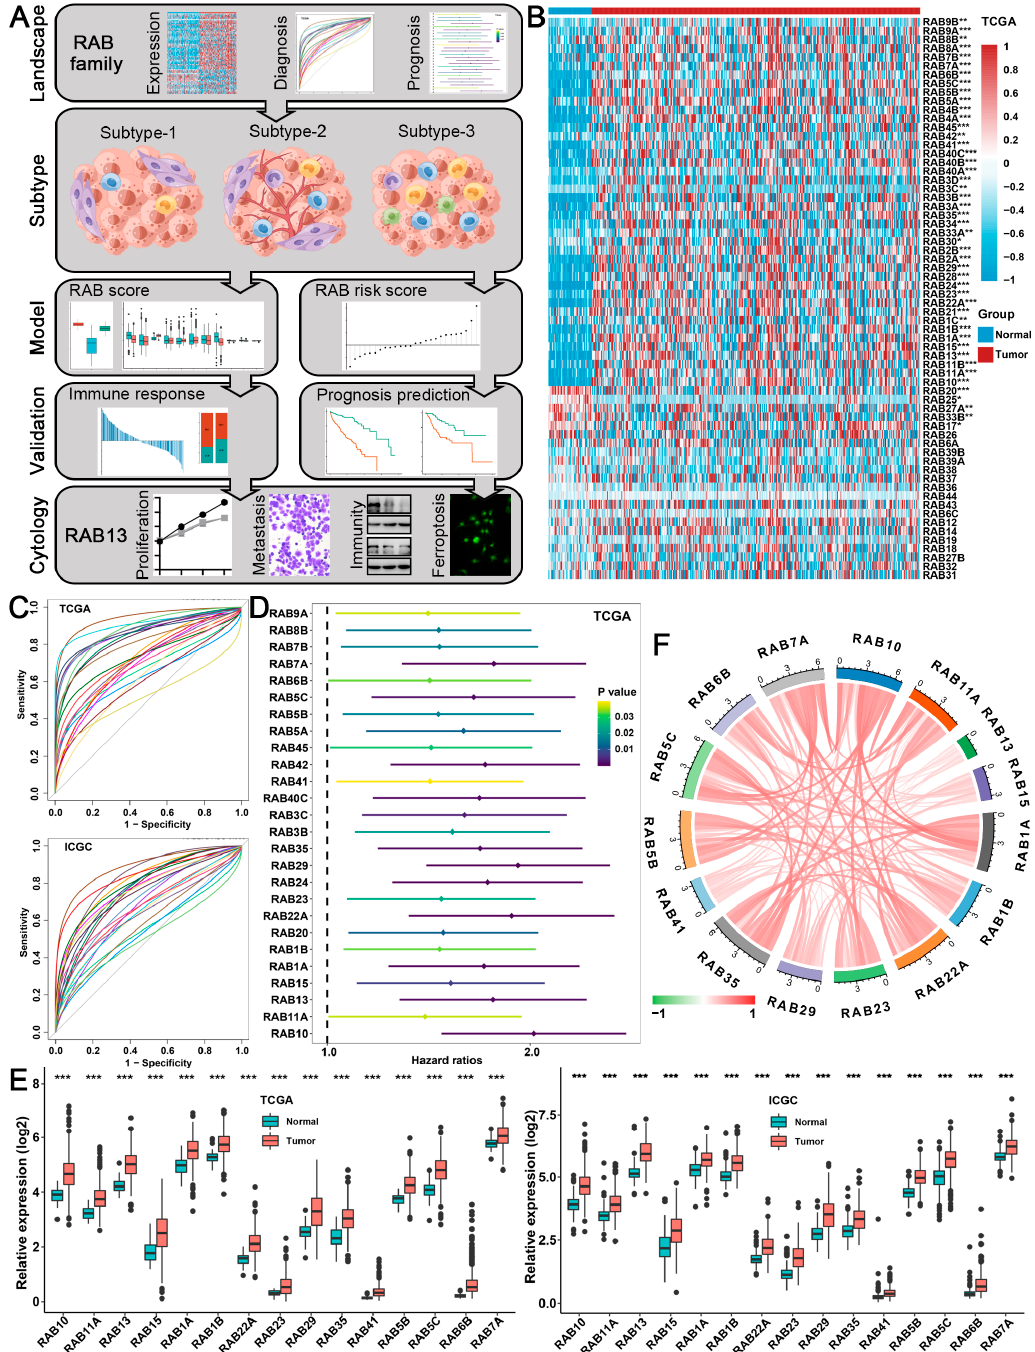
Figure 1. The expression landscape of RAB family genes in HCC. ( A ) Analytical workflow of this study. ( B ) Heatmap of the expression of RAB family genes in HCC and normal liver tissues from the TCGA cohort. ( C ) Receiver operating characteristic (ROC) curve of RAB family members among HCC patients in the TCGA and ICGC cohorts. ( D ) Hazard ratios of survival analyses for RAB family members in the TCGA cohort. ( E ) The relative expression of the 15 critical RAB family genes in the TCGA and ICGC cohorts. ( F ) The interaction among the 15 critical RAB family genes in HCC. The lines linking genes show their interactions, and the thickness of the lines shows the correlation strength. Positive correlations are marked with red lines, and negative correlations are marked with green lines. The asterisks represent the statistical p value (* p < 0.05, ** p < 0.01, and *** p <